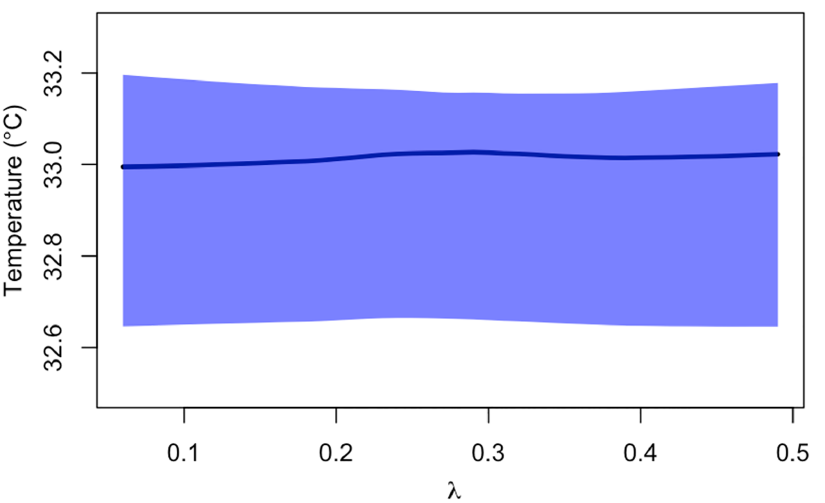
Fig 3. Temperature at which r peaks across a range of mosquito emergence rates λ , obtained by solving for r with 1,000 simulations of R 0 based on Monte Carlo resampling of its three temperature- dependent parameters μ ( T ), n ( T ), and a ( T ) and applying Eq (1). The solid line is the median r at each λ value, and the shadedregion shows the 95% confidenceintervalof r conditionalon λ .